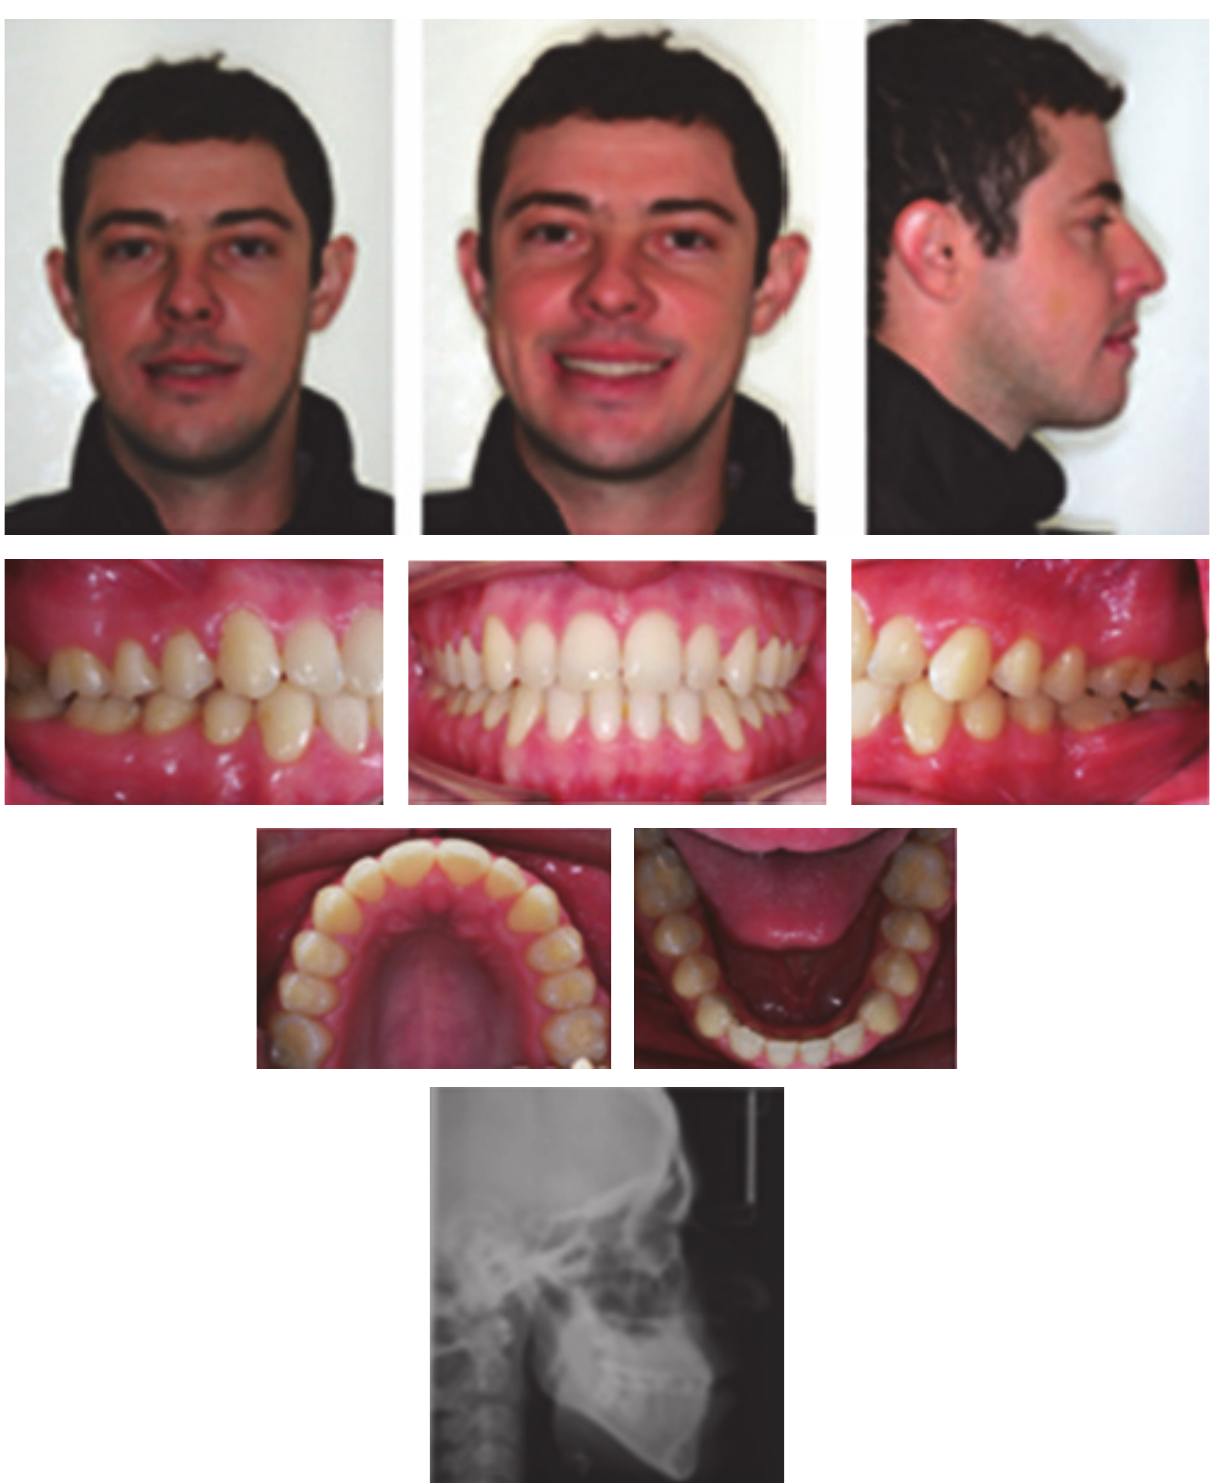
Figure 7: Posttreatment facial and intraoral photographs, and cephalometric